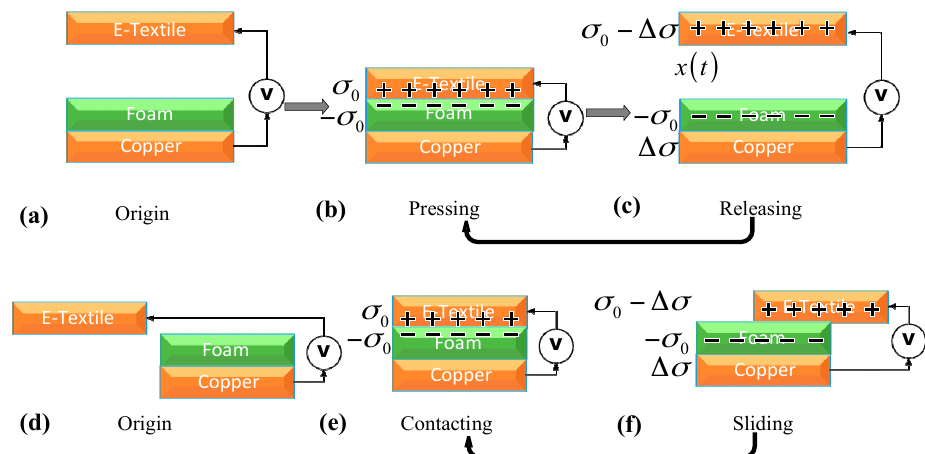
Figure 1. Mechanism of triboelectric energy harvester (pressing and sliding models). For pressing model, ( a ) original position; ( b ) pressing; ( c ) releasing. For sliding model, ( d ) original position; ( e ) contacting; ( f ) sliding.